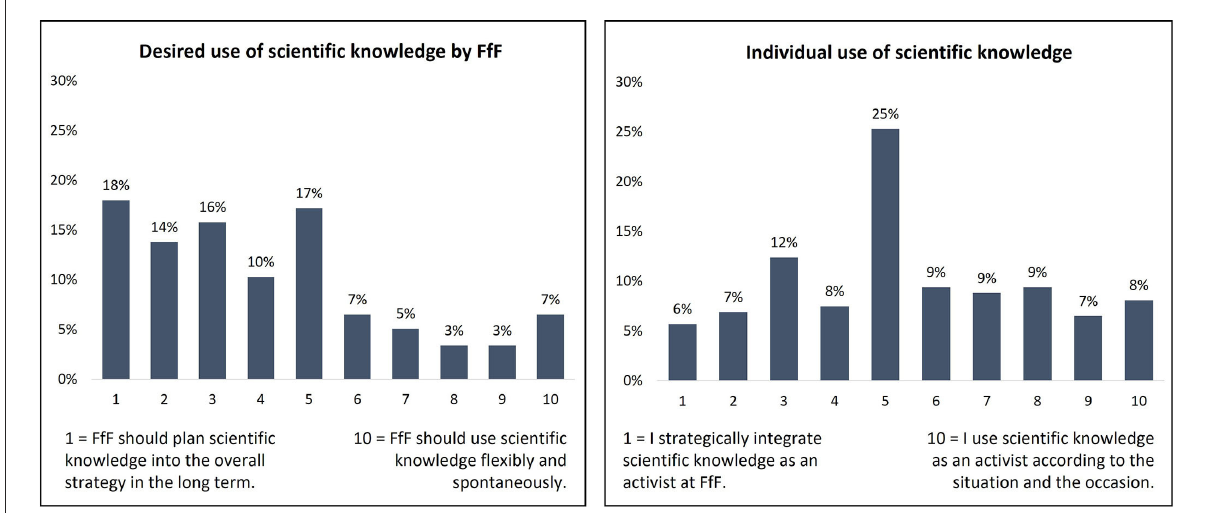
FIGURE2 Use of scientific knowledge by Fridays for Future activists on the movement and individual level in the range between “strategic” and